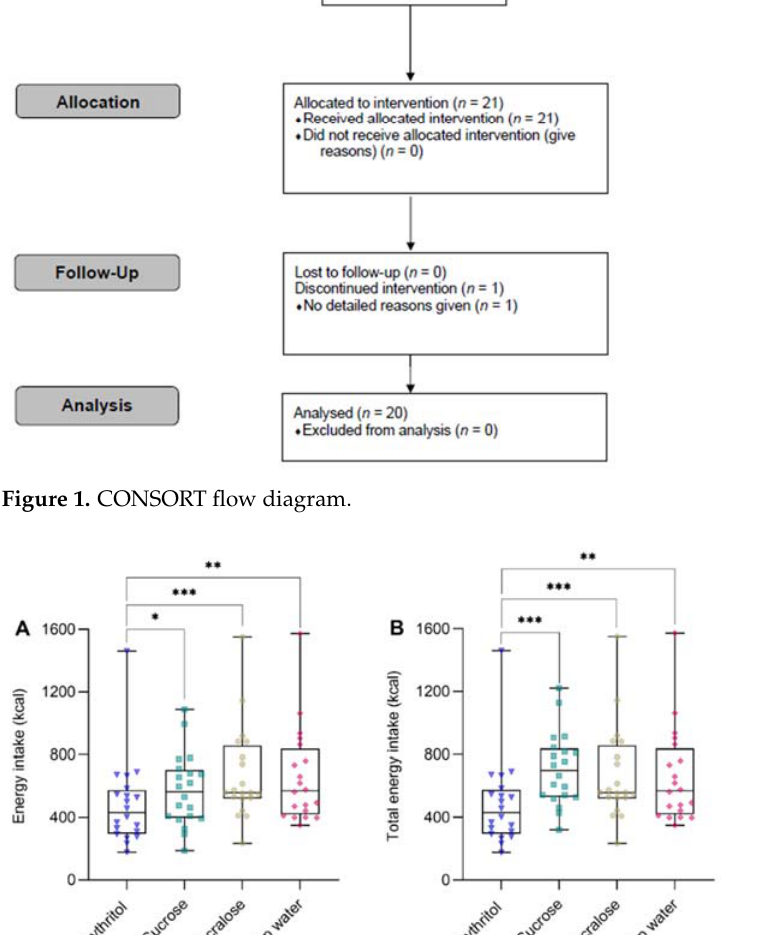
Figure 1. CONSORT flow diagram.